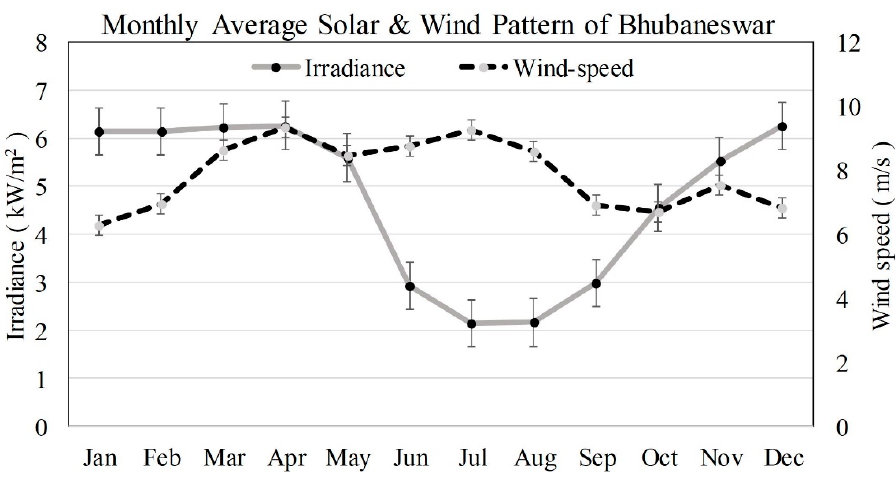
Figure 4. Monthly average solar/wind pattern of Bhubaneswar, India, used in this study.